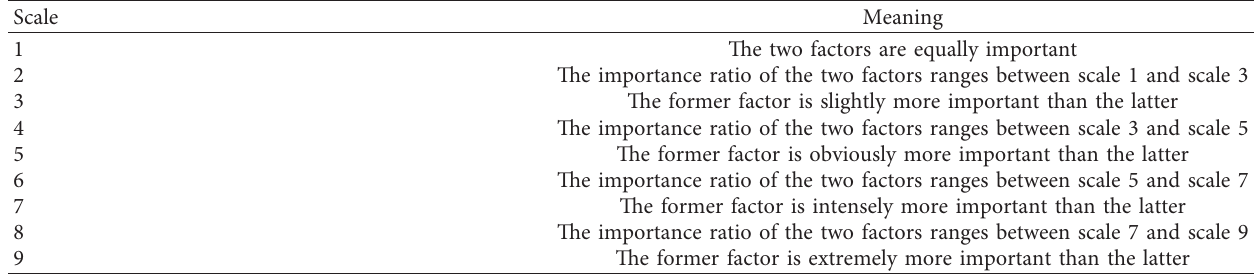
Table 4: Meanings of scales in the model.